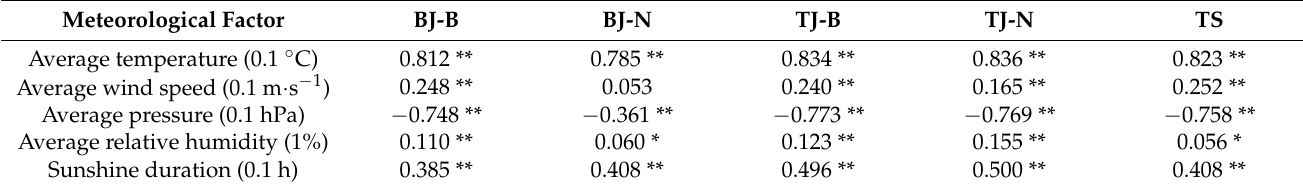
Table 3. Correlations of surface ozone concentration with meteorological